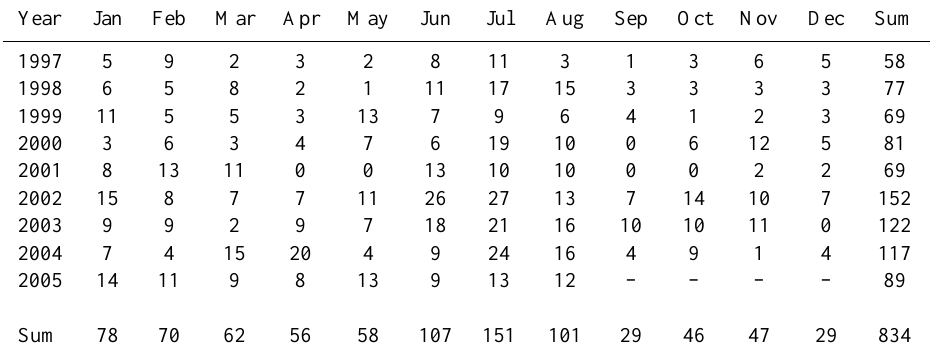
Table 1. Number of ALOMAR RMR lidar measurements per month which entered the temperature climatology. All measurements longer than two hours were included. The longest measurement lasted for 132h. In September 2005 the telescopes received a major upgrade changing their characteristics. Therefore we restricted the analysis to the data up to August 2005.